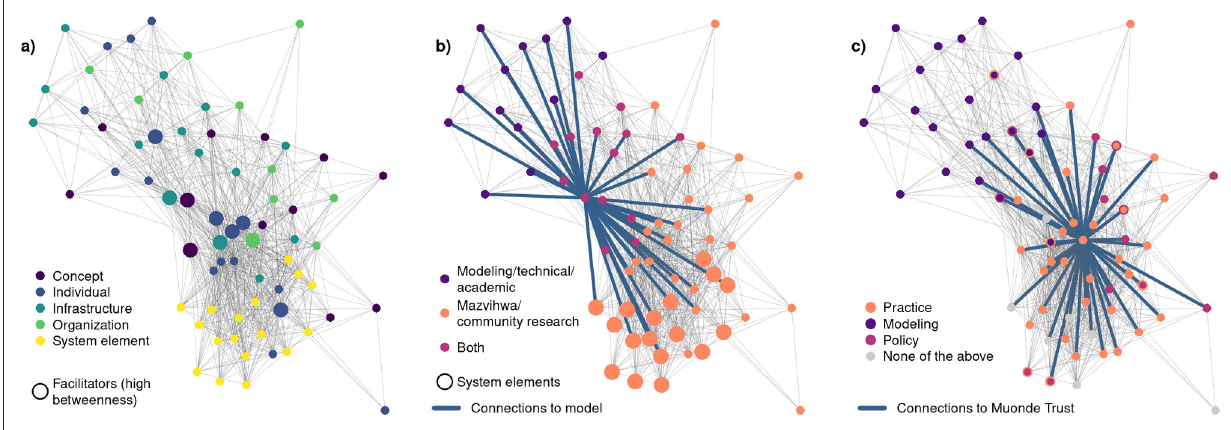
Figure 3 Network diagram showing the connections between different elements of the situation. (a) Element types and key bridging facilitators: Elements are colored by their category; those with the top 10 betweenness scores are larger. (b) Model as boundary object: Elements are colored based on their predominant research context—Mazvihwa Communal Area/community-based ( orange ), academic/modeling/technical ( purple ), or some combination of both ( magenta ). Within that, the on-the-ground study system elements are larger, and the model’s connections to other elements are shown in thicker lines. (c) Muonde as innovation facilitator: Elements are colored by their community context – modeling ( purple ), policy ( magenta ), on-the-ground practice ( orange ), or none of the above ( gray ). Elements with multiple contexts appear with their dominant context color in the center and a border color that corresponds with their secondary context. Connections to the Muonde Trust are shown in thicker